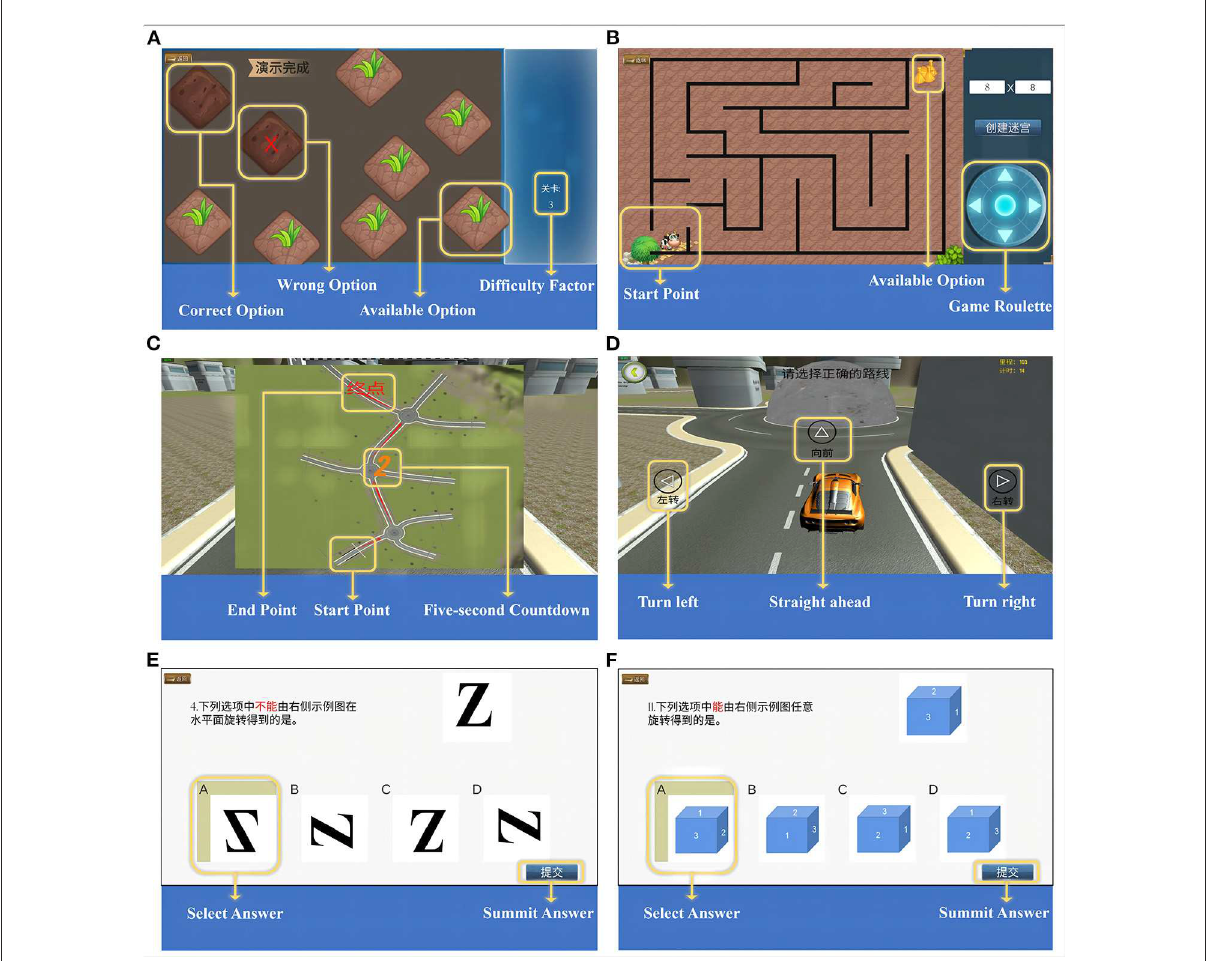
FIGURE1 Visuospatial Cognition Assessment System (VCAS). (A) Diagram of weeding test. (B) Diagram of maze test, take map 8 × 8 as an example. (C) The map of three-dimensional driving (3D driving), and (D) The diagram of 3D driving, take one map as an example. (E) 2D-object of card rotation test, and (F) 3D-object of card rotation